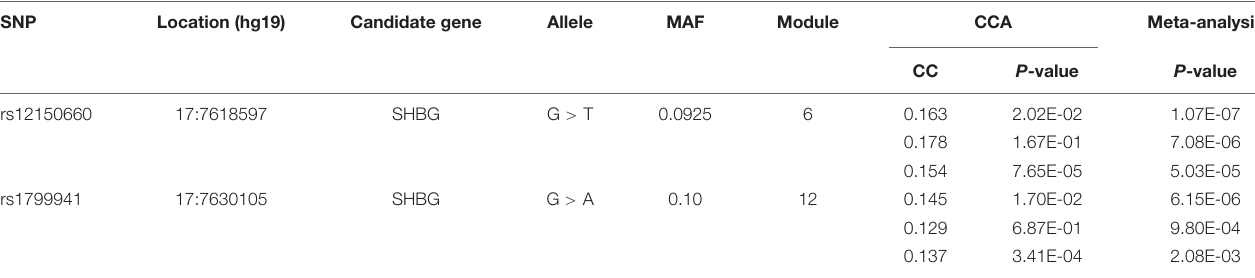
TABLE 1 | Discovery and meta-analysis results of rs12150660 and rs1799941 for the 3D facial modules. SNP Location